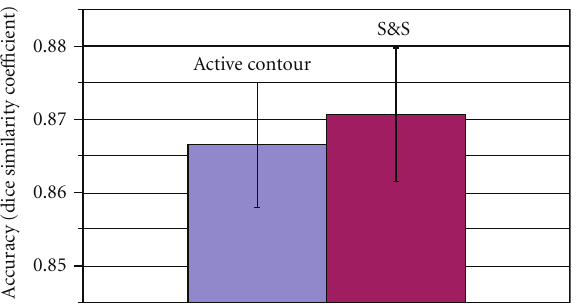
Figure 15: Bar graph showing the mean 3D segmentation agree- ment to all expert segmentations over all data sets for both ITK- SNAP active contour method (blue) and the Shells and Spheres method (maroon). Error bars show the standard error of the mean